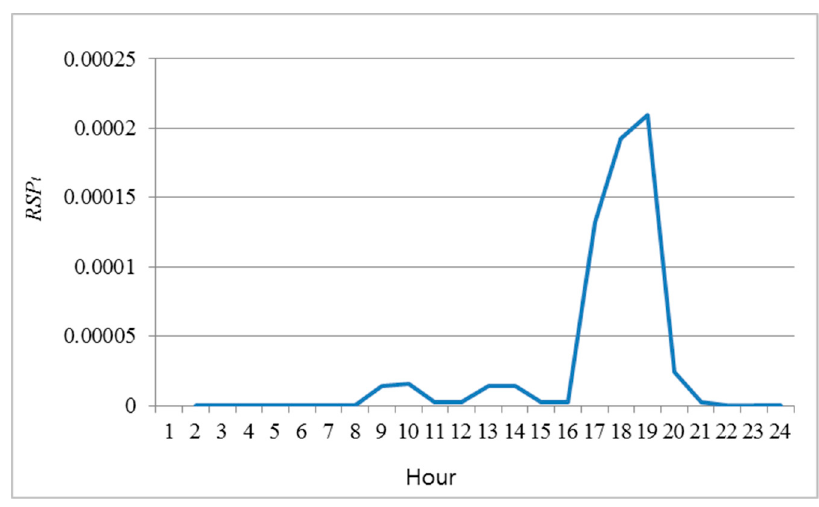
Figure 6. Hourly RSP t . Table 2. Scenarios for three parameters: net load, increased variability, and uncertainty. Scenario,